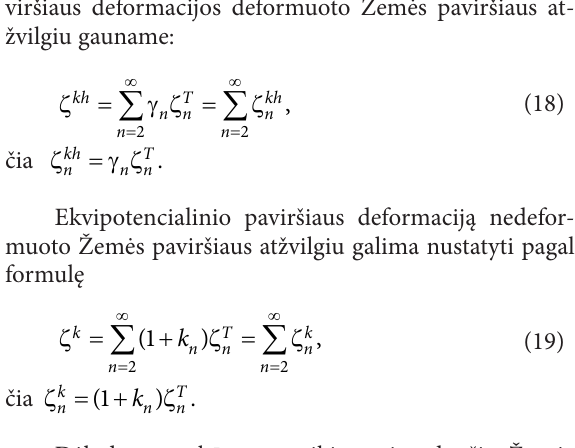
įtakos turi formulės (6) narys ( n = 3) (3 pav.), kitimo ne-